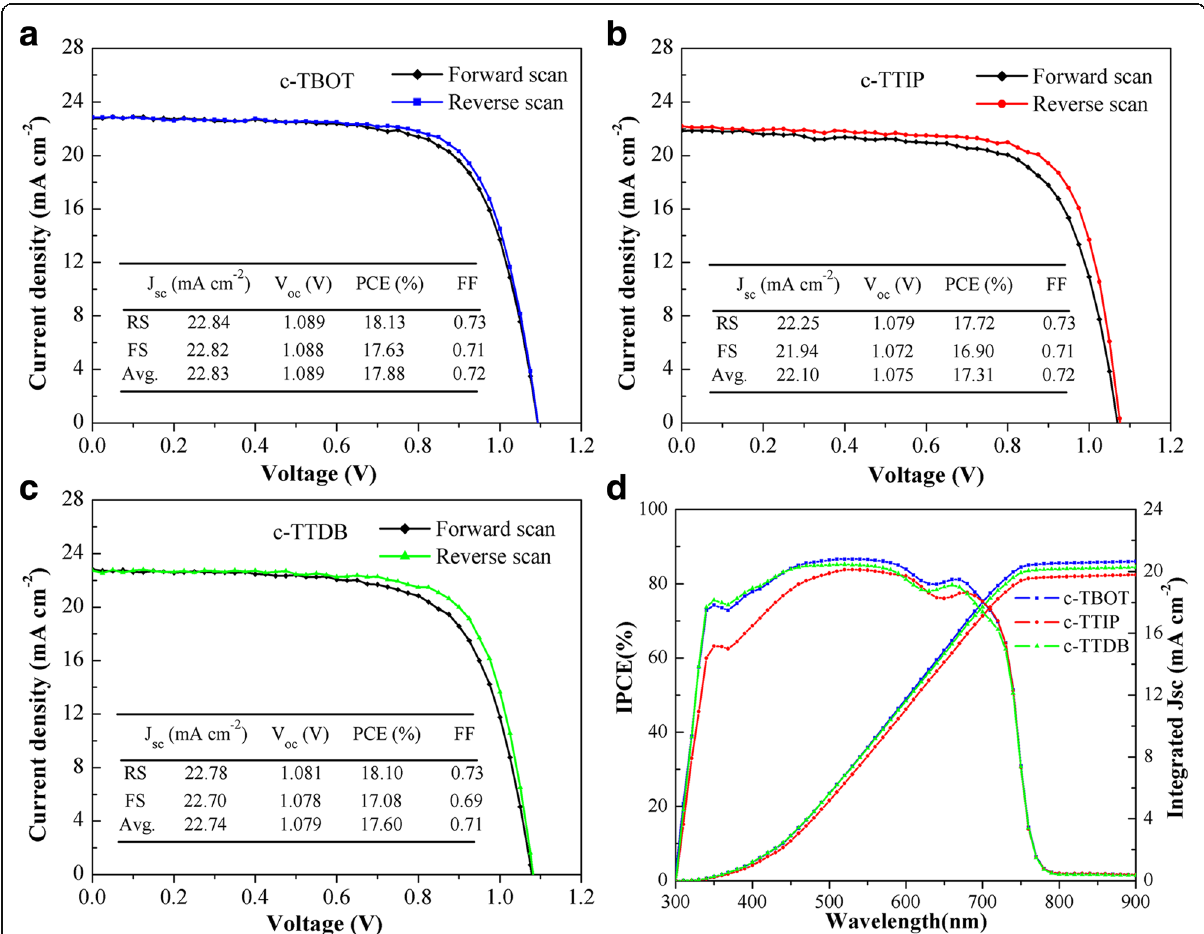
Fig. 7 a – d Current density-voltage ( J - V ) curves and IPCE for the best cells based on different compact